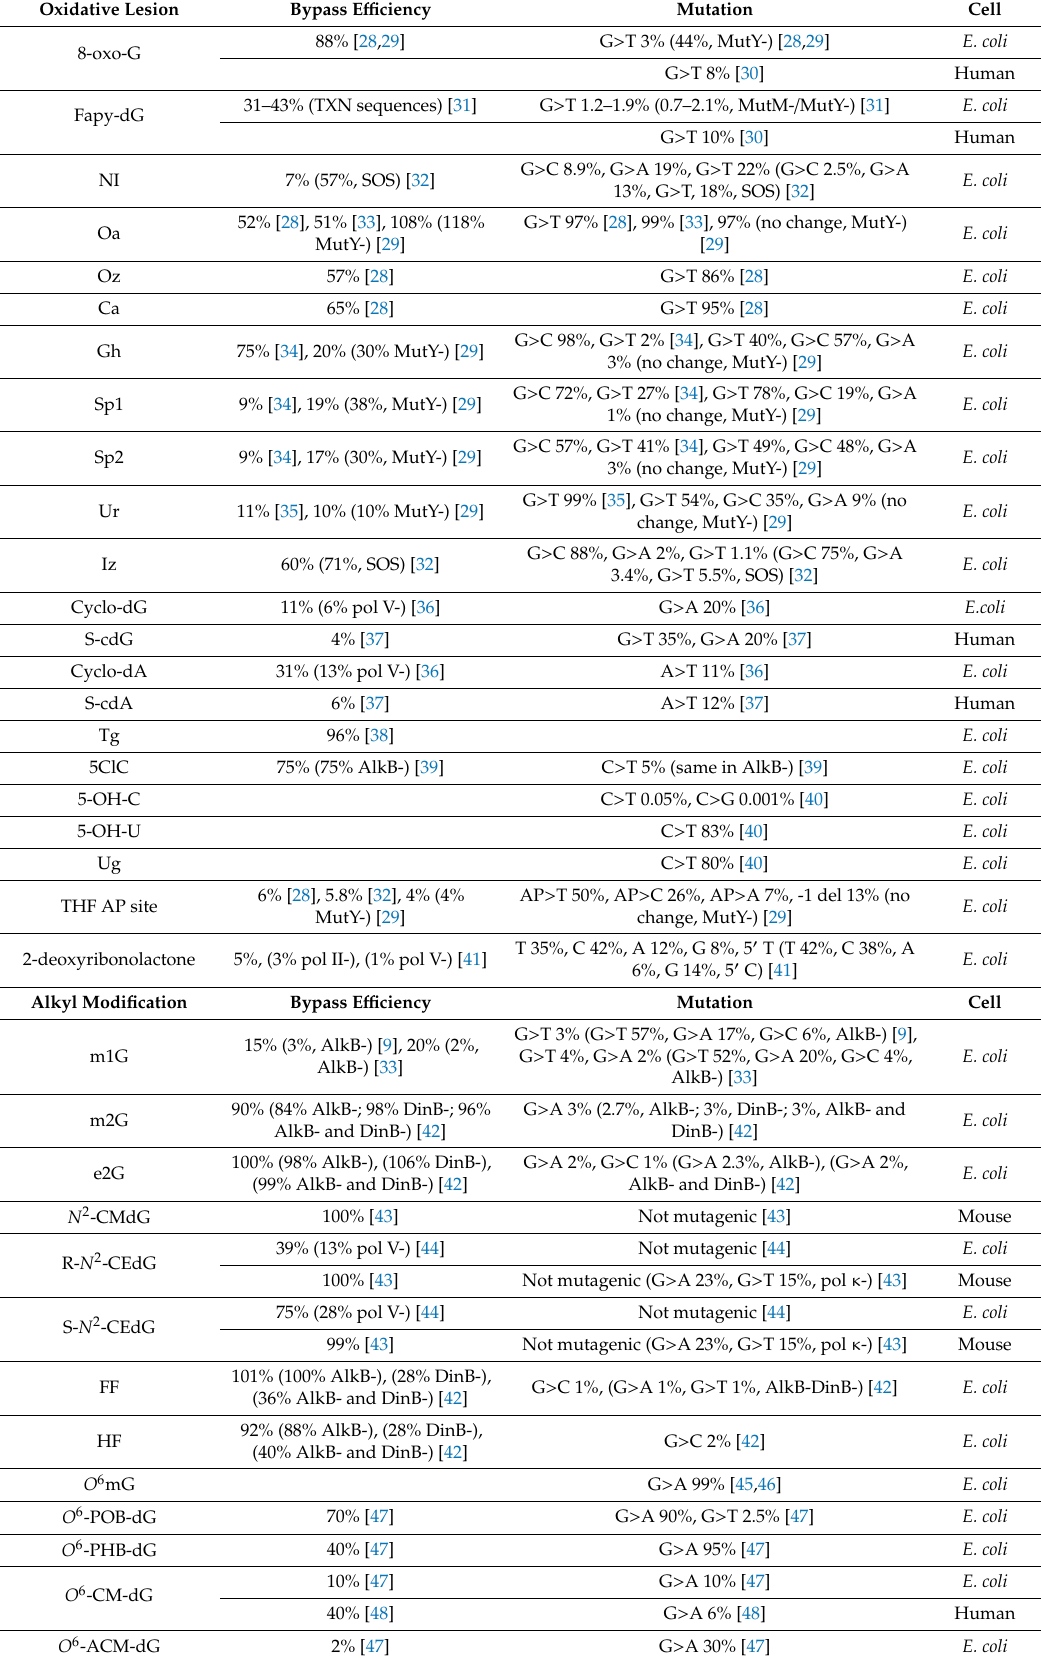
Table 1. Bypass e ffi ciency and mutagenicity of DNA